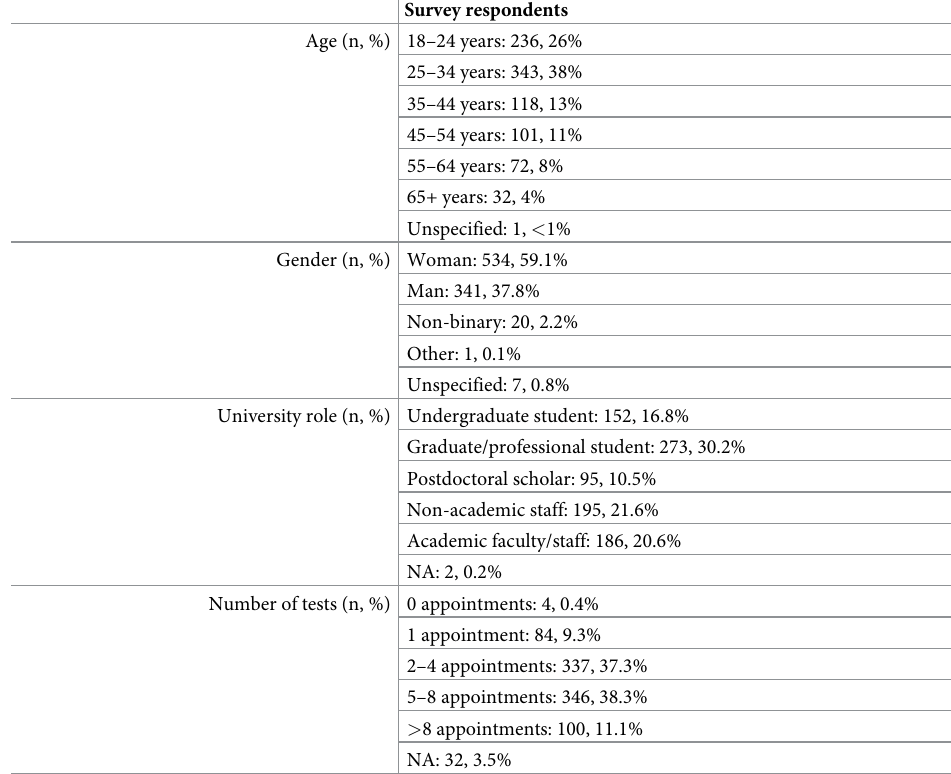
Table 2. Characteristics of exit survey respondents (n = 903).